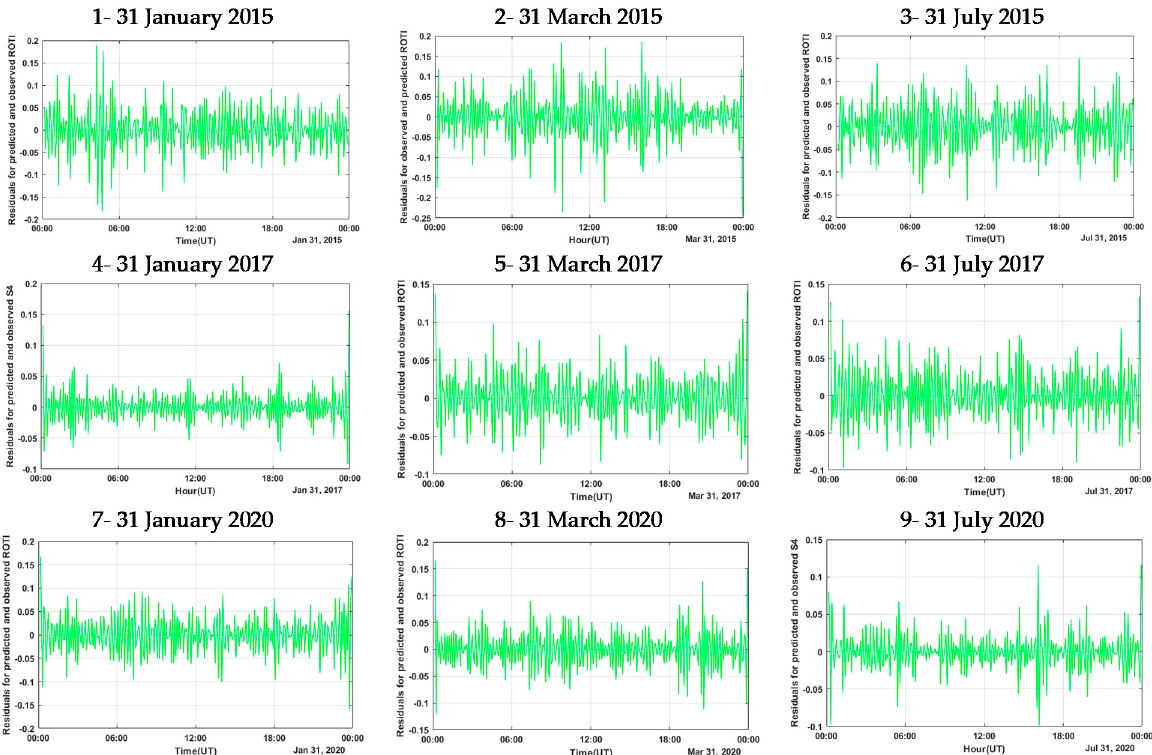
Figure 6. The residual vectors of observed minus predicted ROTI values during 24 h on 31 January, 31 March, and 31 July in 2015, 2017, and 2020.